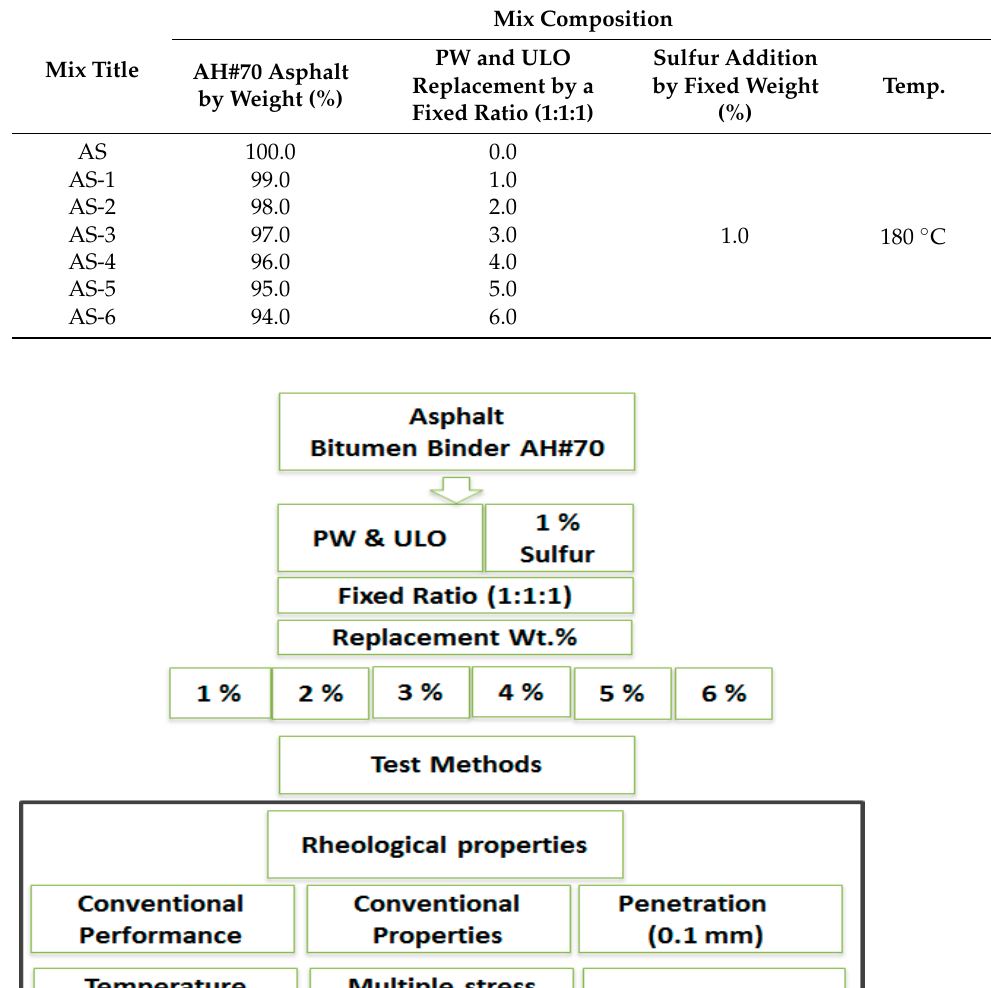
Table 4. Mix composition of PW and ULO-modified asphalt patches.